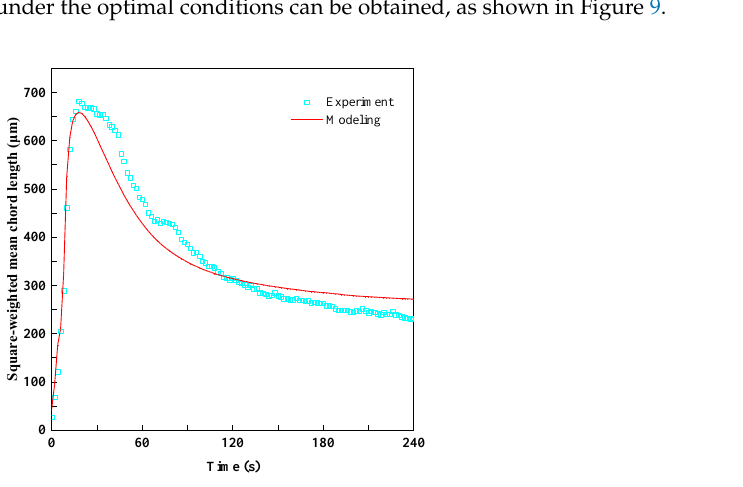
Figure 9. Dynamic evolution of the square-weighted mean chord length of floc obtained by experi- ment (symbols) and modeling (continuous lines) under the optimal conditions.